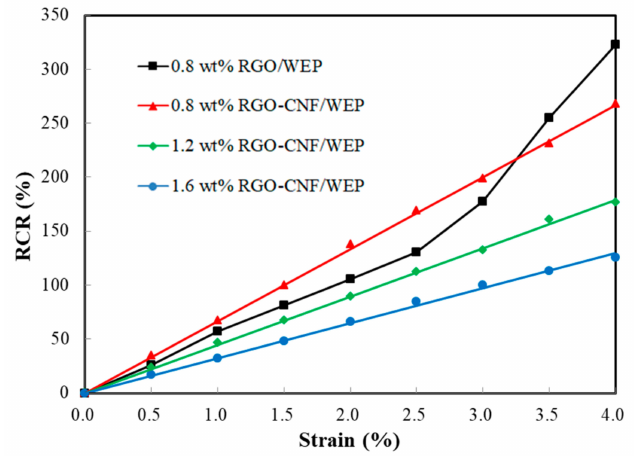
Figure 6. The correlation of RCR and strain within a 4% strain range.